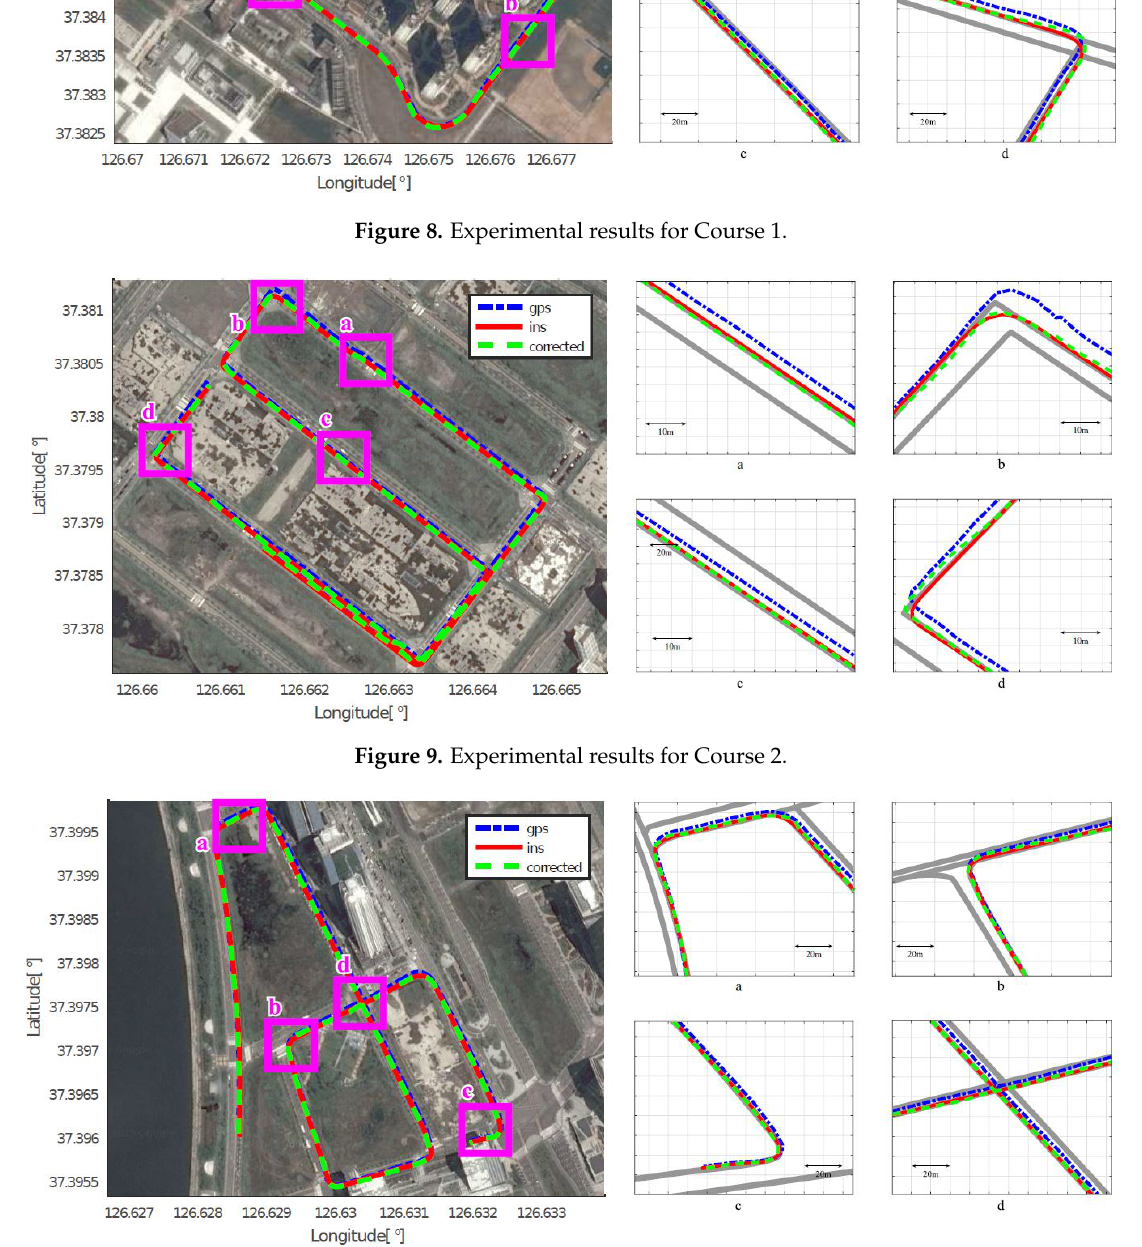
Figure 10. Experimental results for Course